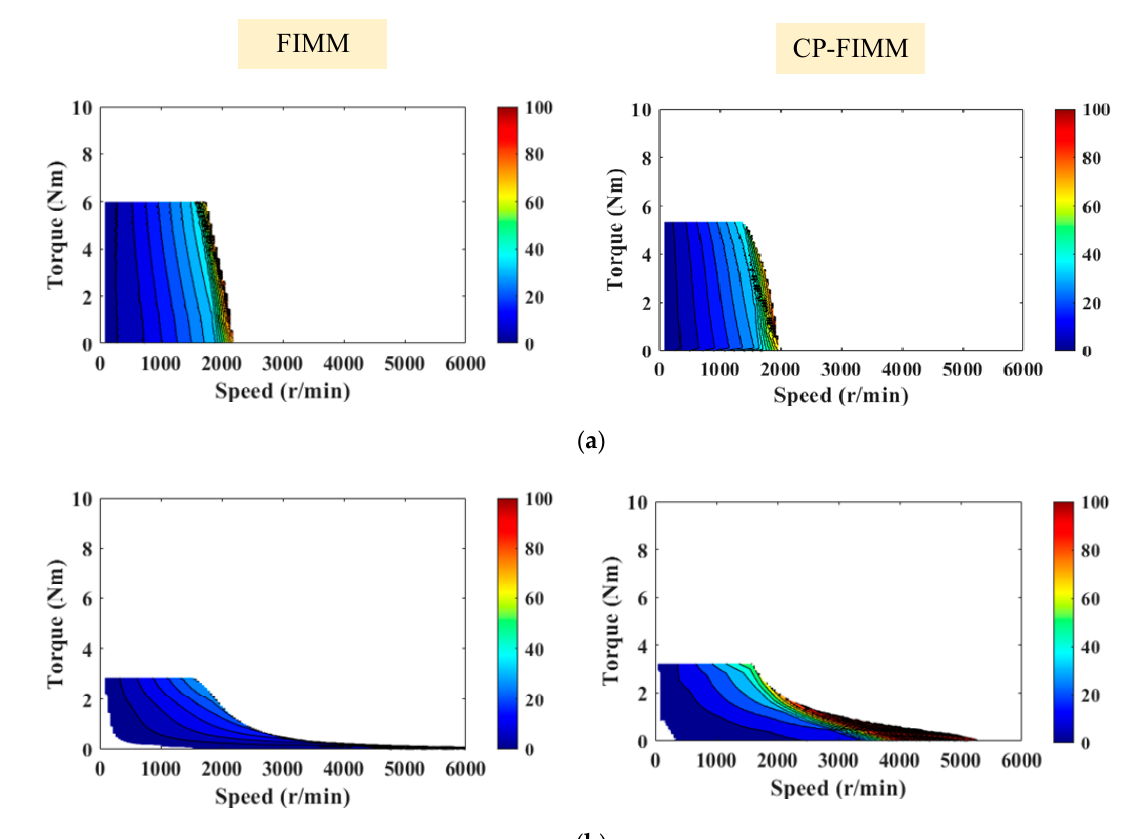
Figure 17. Copper loss maps of FIMM and CP-FIMM. ( a ) Flux-enhanced; ( b ) flux-weakened.